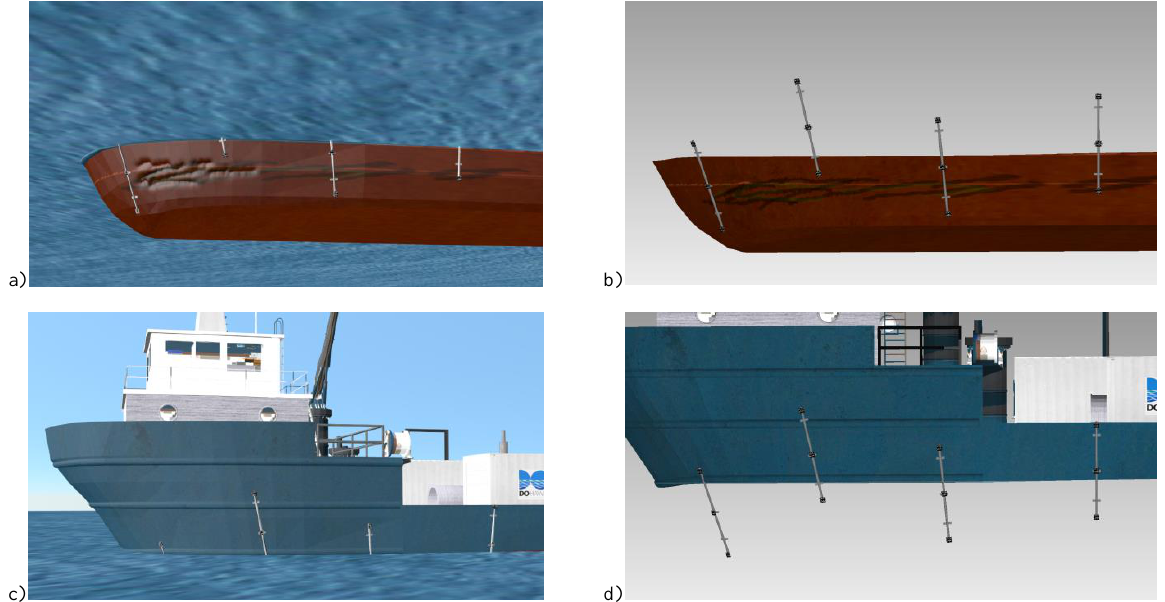
Figure 5. – Target-based procedure for the alignment of the two separate surveys above and below the waterline.